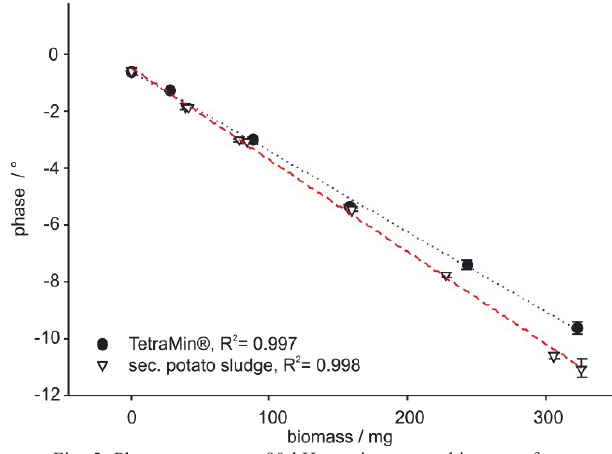
Fig. 5: Phase response at 90 kHz against worm biomass of two different kinds of Lumbriculus variegatus measured in tap water. The two groups of worms were fed with TetraMin ® and secondary potato sludge, respectively.